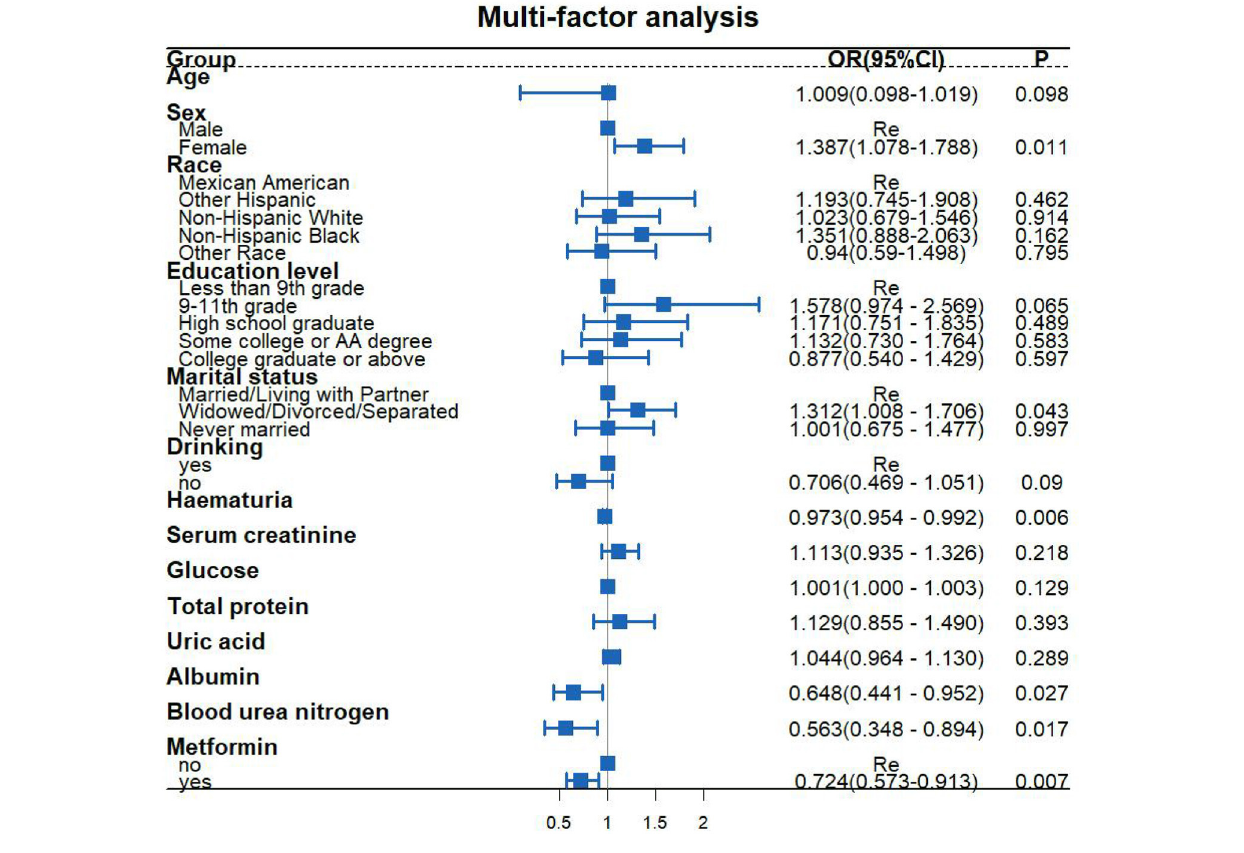
FIGURE 2 | Multi-factor analysis.